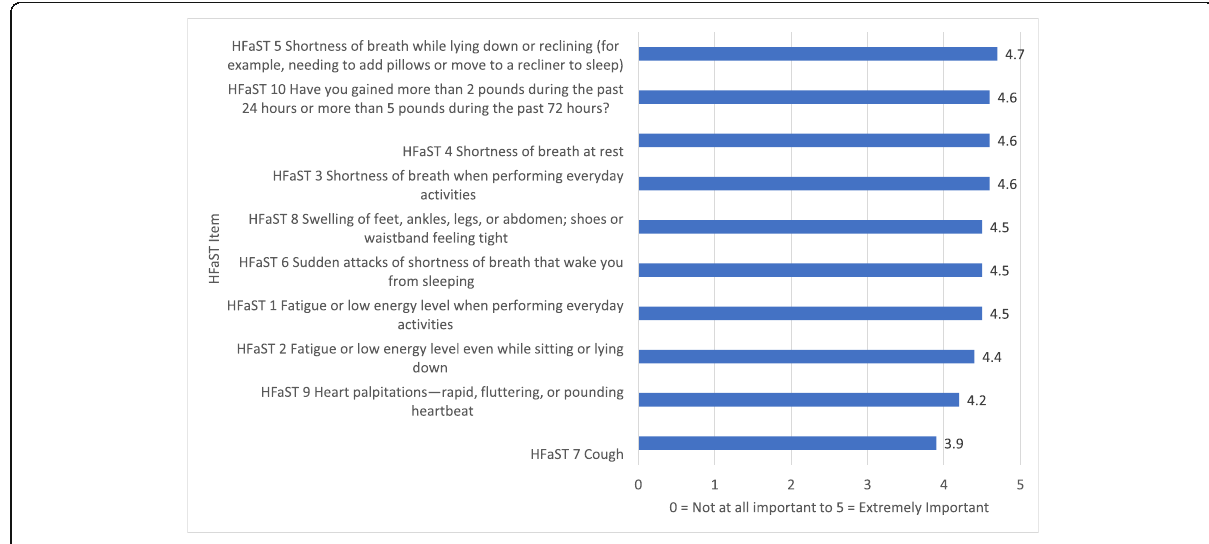
Fig. 2 Draft HFaST Item Text and Ratings of Symptom Importance Per HCPs ( n = 10)